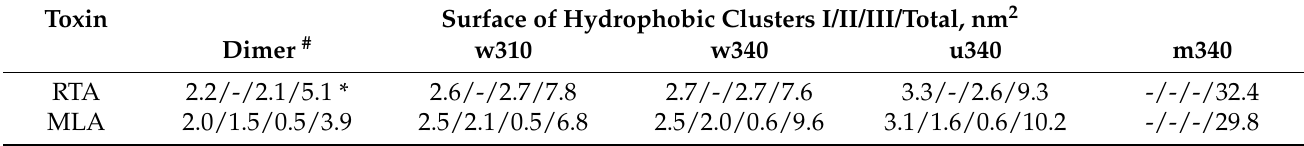
Table 3. Hydrophobic properties of the RTA and MLA surfaces in different environments.